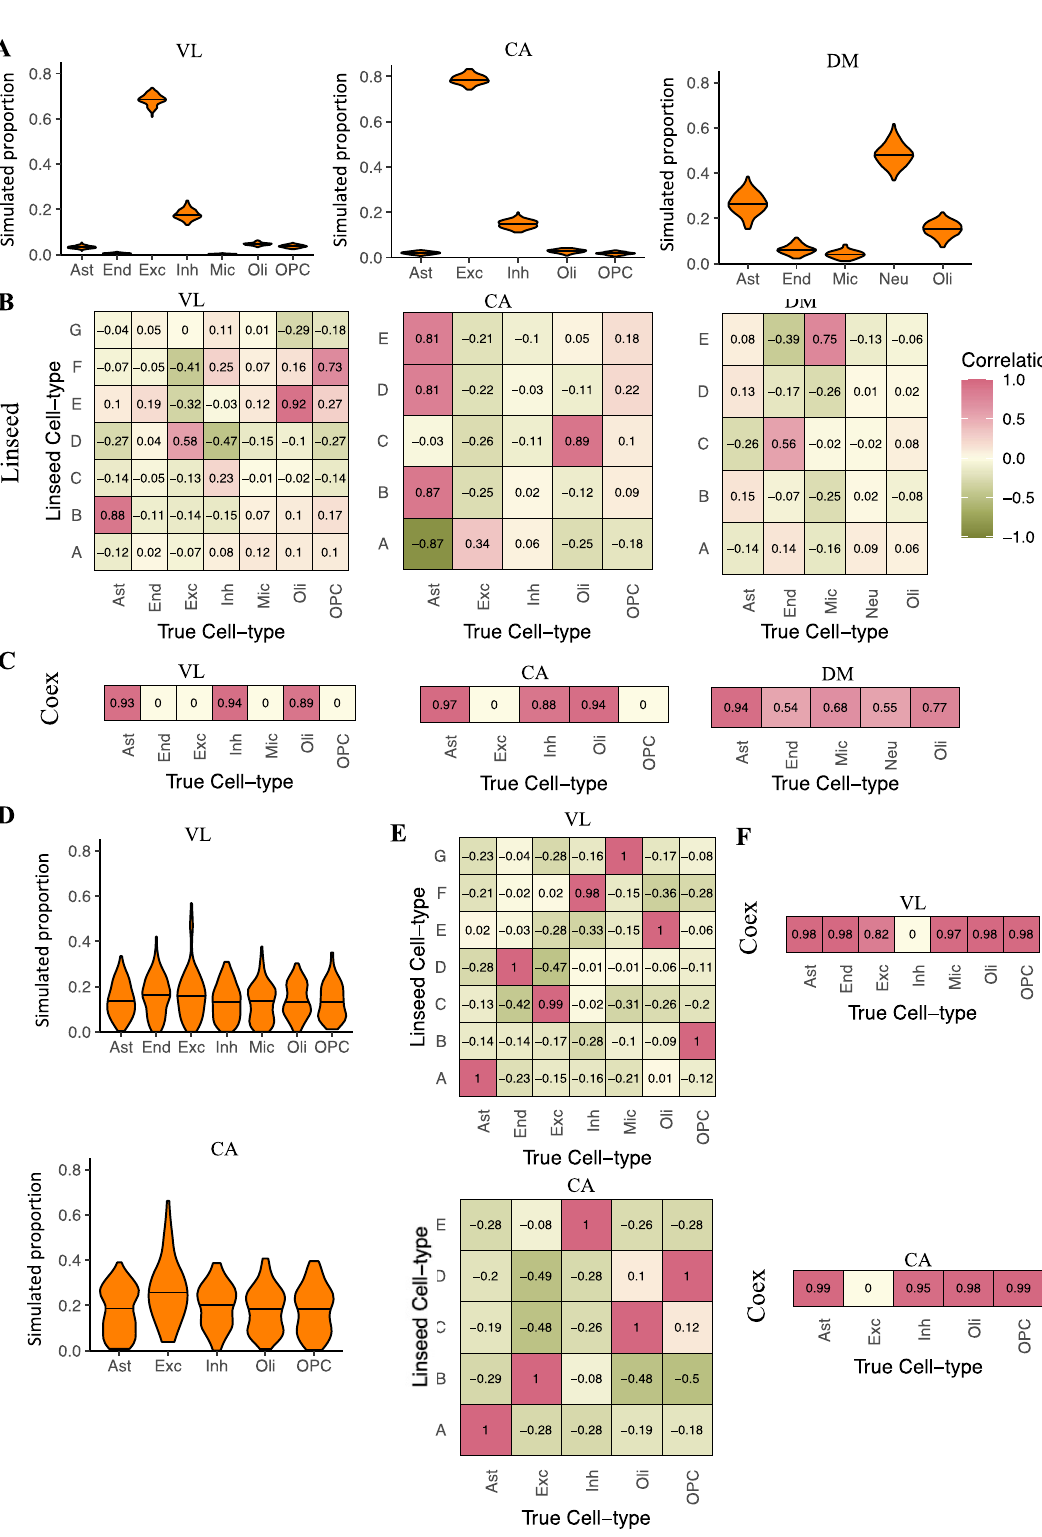
how cellular composition in fl uences DE analyses, in particular: (i) how much should cell-type composition differ between two groups of brain samples to lead to false positive results in DE analyses, and (ii) what is the best approach for correcting cell- type composition differences in DE